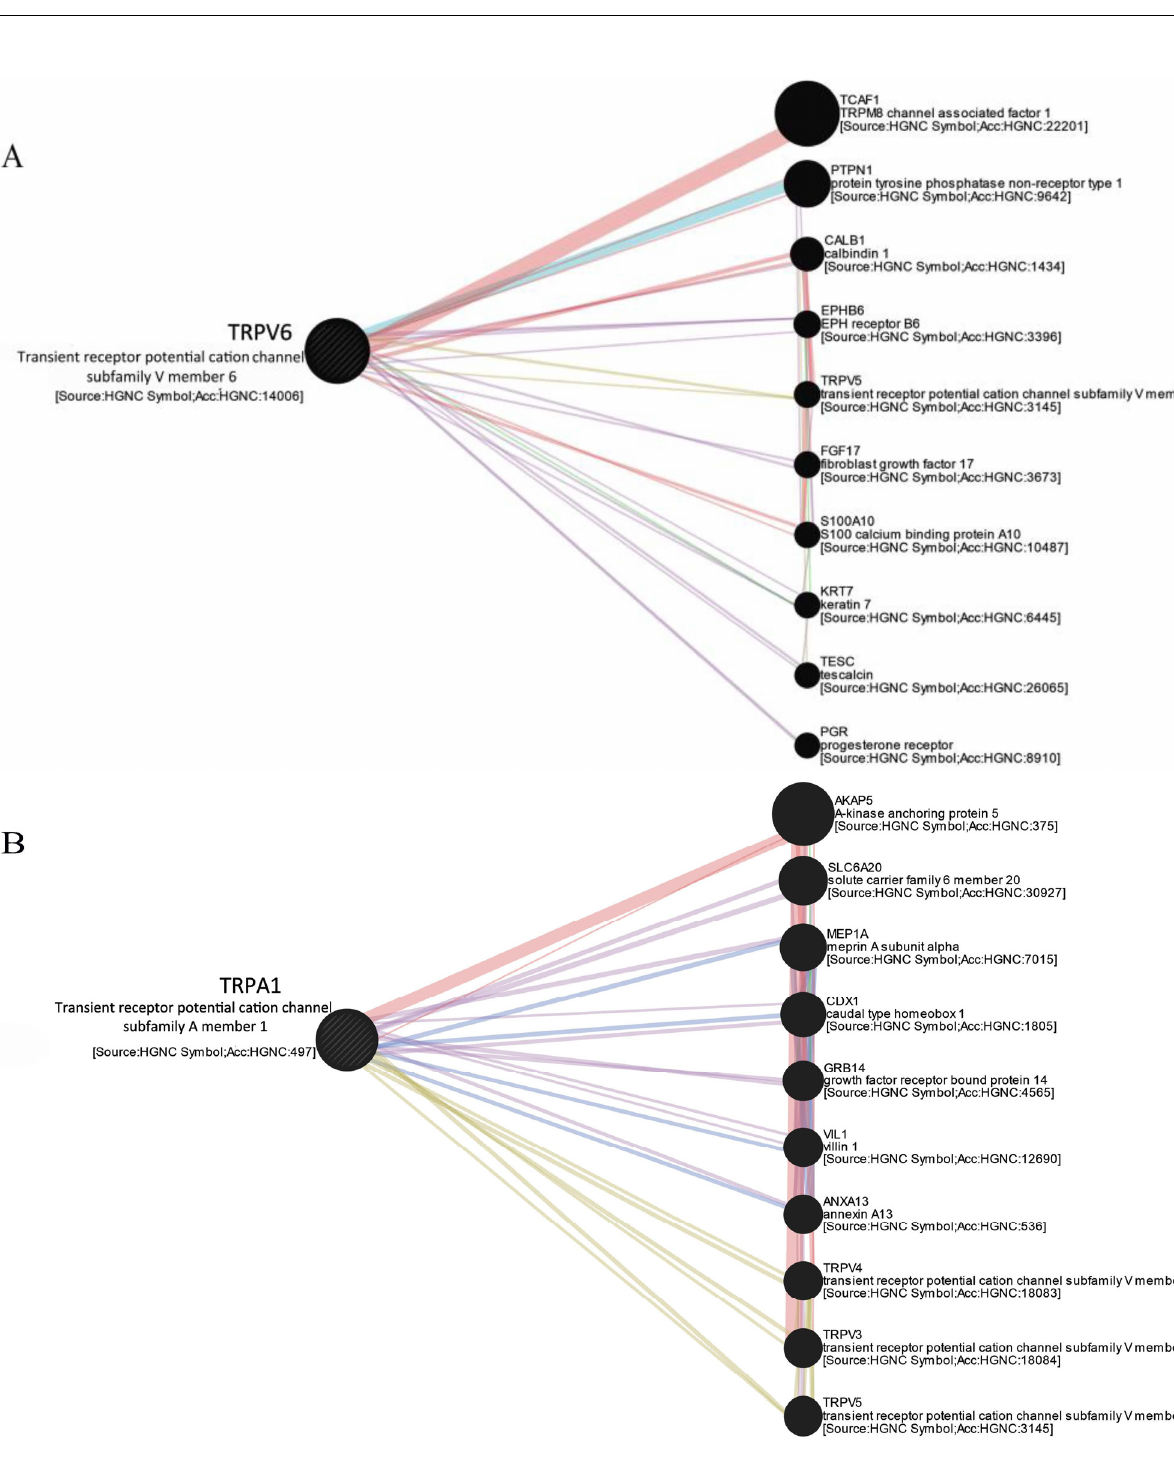
Figure 3. Co-expression/pathway/predicted analysis of TRPV6 ( A ), TRPA1 ( B ), and TRPM8 ( C ) and 10 related genes according to human expression data in GeneMANIA (https://genemania.org/), cre- ated on 27 July 2022. 2.1.3. Selected TRP Genes Differently Correlates with Tumor Stages and Metastasis Furthermore, we evaluated the relationship between the TRP genes and the follow- ing clinicopathological features: tumor size, histologic differentiation, AJCC TNM staging, nodal status, and distant metastasis. For this analysis, we used the GEPIA and UALCAN web platforms. According to the AJCC (American Joint Committee on Cancer), the indi- vidual PDAC stages were divided into four stages (I–IV), and six sub-stages were classi- fied as IA, IB, IIA, IIB, III, and IV.